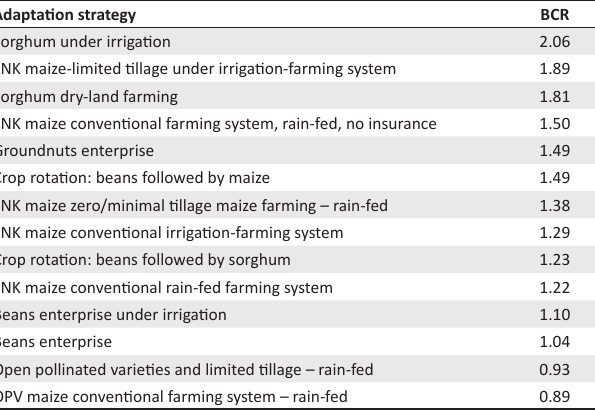
TABLE 7: Benefit-cost ratios for the selected adaptation strategies for Lambani. Adaptation